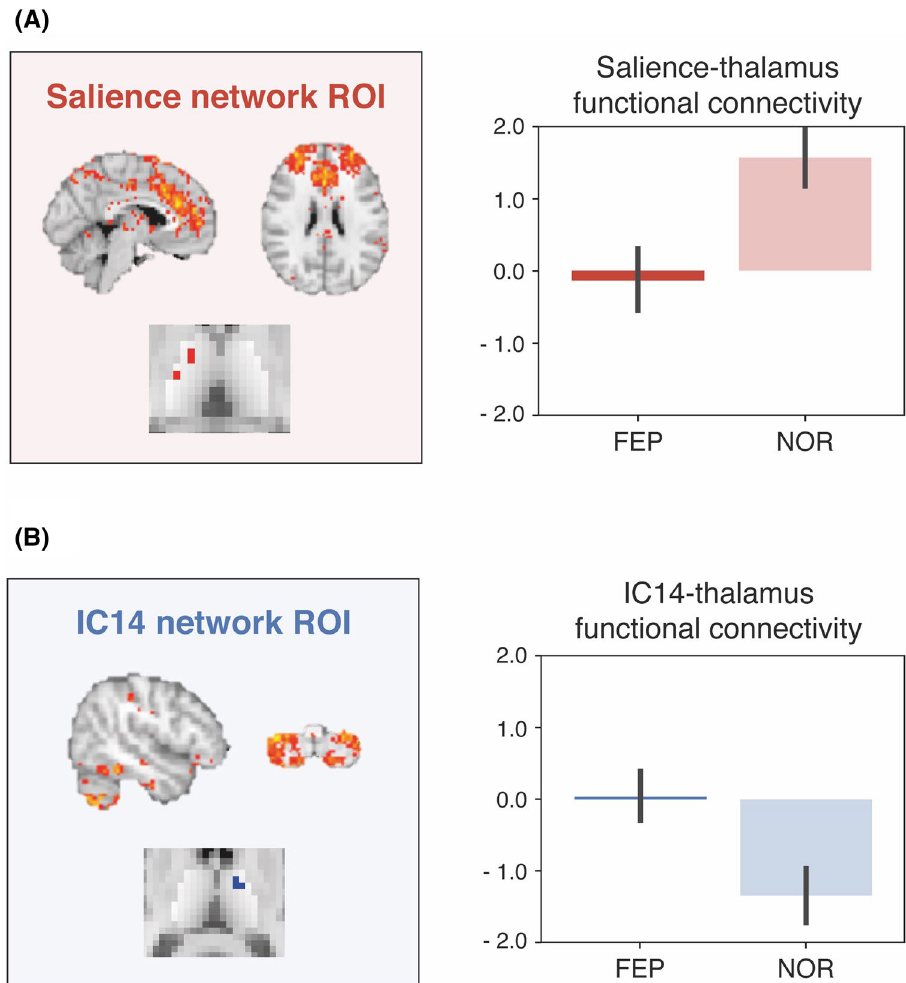
Figure 2. Altered functional connectivity of the network ROIs with the thalamus in the FEP patients. Red foci on the thalamus localize where patients exhibited reduced connectivity with the network ROI; blue foci on the thalamus localize where patients exhibited stronger connectivity with the network ROI. Bar graphs represent mean functional connectivity